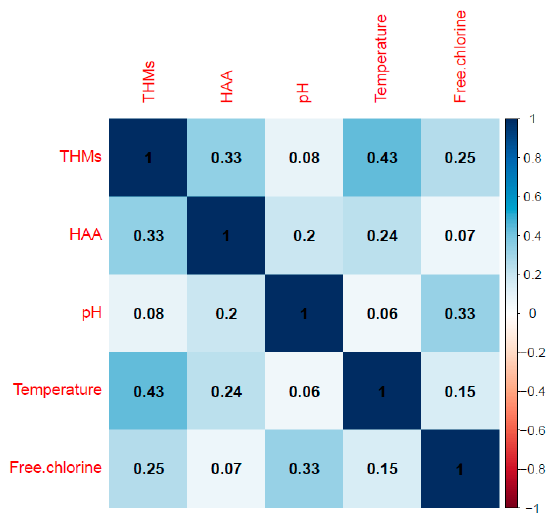
Figure 5. Correlation graph. Table 5. Correlation matrix.